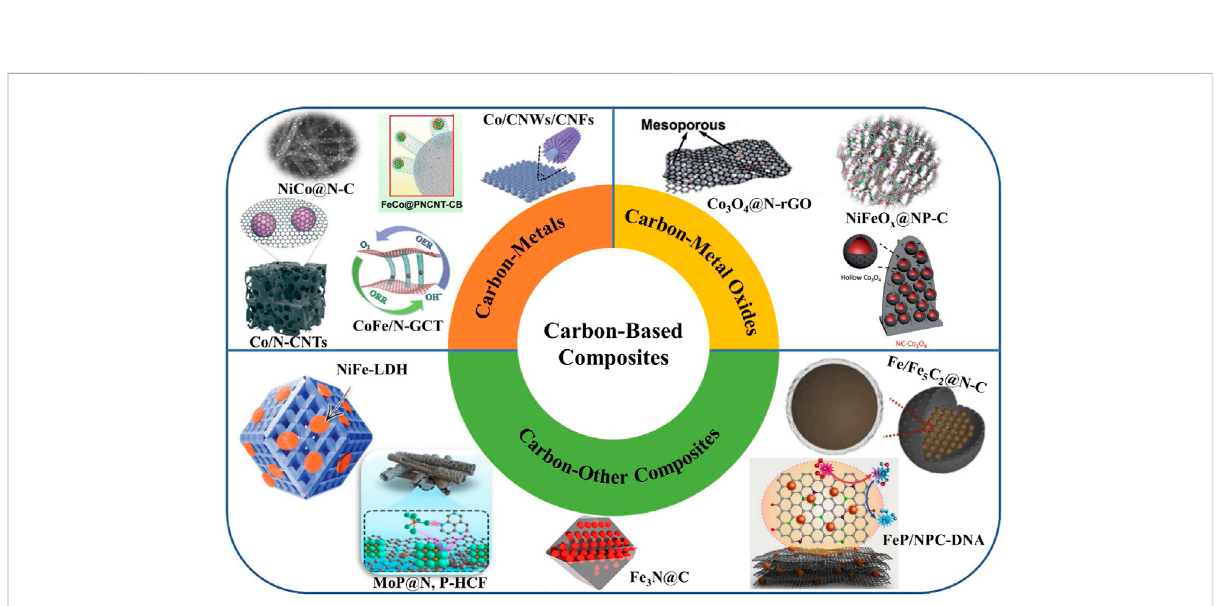
Summary of the carbon-based composites used to boost the electrochemical performances of zinc-air batteries. Reprinted with permission from (Guan et al., 2017; Wang et al., 2017; Fu et al., 2018; Li et al., 2018; Liu et al., 2018; Xia et al., 2021) with permission from WILEY-VCH. Reprinted with permission from (Chen et al., 2018; Song et al., 2019; He et al., 2021; Radwan et al., 2021; Yu et al., 2022; Zhu and Zhang, 2022) with permission from Elsevier. Reprinted with permission from (Chen et al., 2022) with permission from The Royal Society of